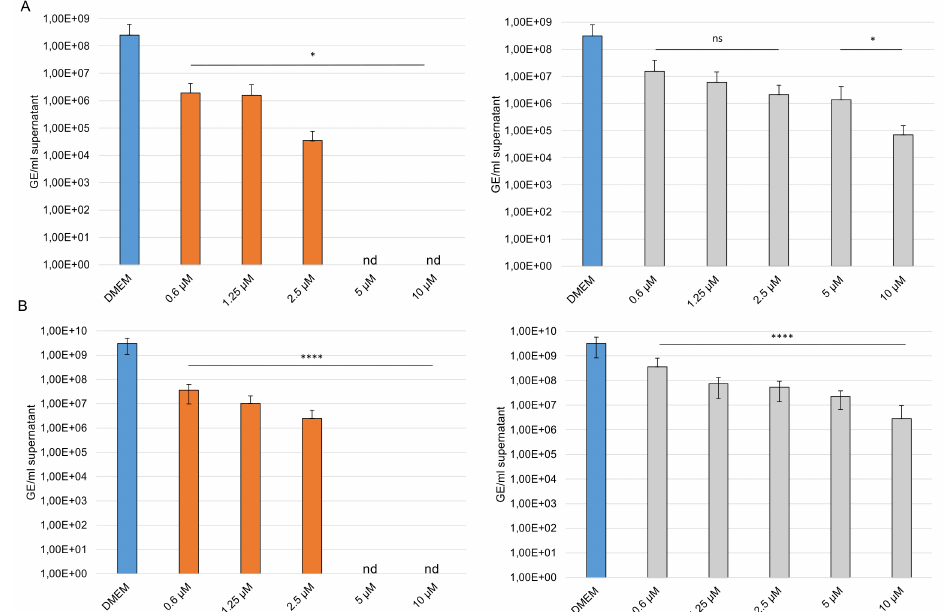
Figure 10. Effects of the high-sulfated GAGs on SARS-CoV-2 variants. Caco-2 cells were inoculated with a 2-fold dilution series of sHA3 (orange) or sCS3 (grey) prior and after infection with SARS- CoV-2 B.1.1.7 ( A ) or B.1.351 ( B ) (MOI 0.001). At 24 hpi the supernatants were harvested, and viral RNA was extracted. In the following, real-time quantitative RT PCR concentration of envelope gene copy numbers was determined. Values shown represent three independent experiments. * p <